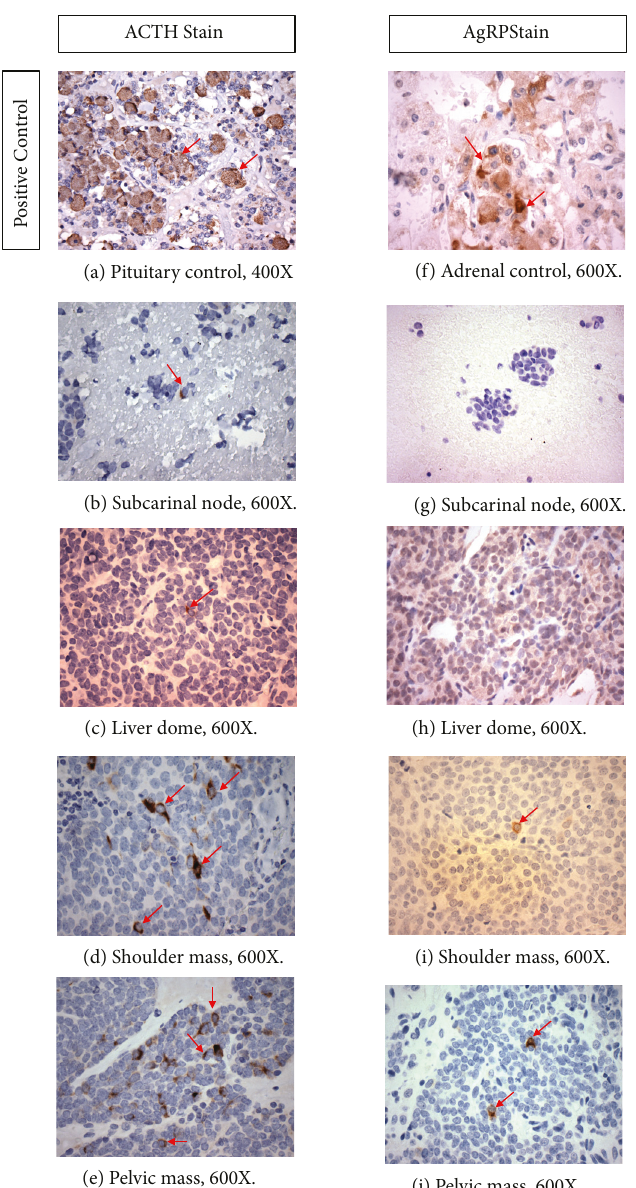
Figure 1: Histopathology and immunohistochemistry of metastatic NEC biopsy specimens : (a) Positive control: ACTH staining in normal pituitary tissue. Stained cells (red arrows) have brown cytoplasm. (b) Rare ACTH-positive cells in the subcarinal node that provided the initial diagnosis of NET and in (c) liver dome biopsied 3.5 years later. Increase in staining intensity and number of cells staining positive for ACTH in (d) shoulder mass and (e) pelvic mass, biopsied 4 and 4.5 years after initial diagnosis, respectively. (f) Positive control: AgRP staining in normal adrenal tissue. No staining for AgRP in specimens biopsied earlier in the disease course: (g) subcarinal node and (h) liver dome. Specimens biopsied later: (i) shoulder mass and (j) pelvic mass: show rare cells staining for